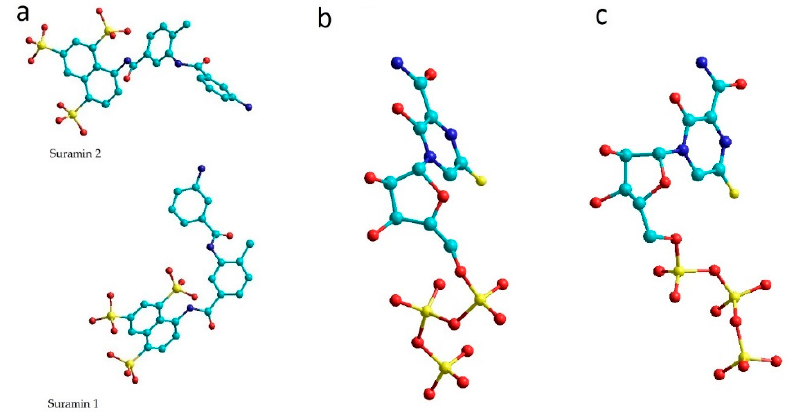
Figure 1. Ligands of 7D4F ( a ), 7CTT ( b ) and 7AAP ( c ) complexes. (colors show: light green—C, yellow—S, red—O, blue—N)